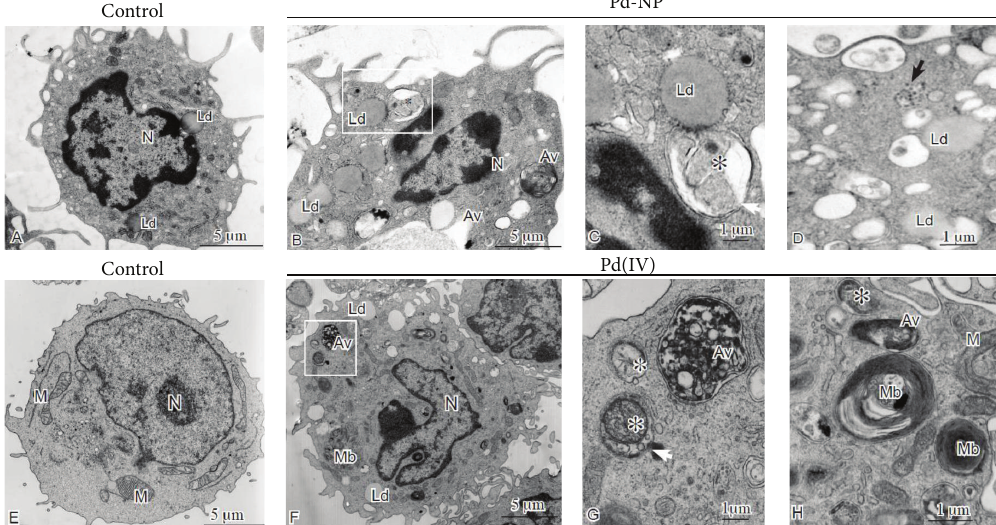
Figure 3: Ultrastructural alterations observed in peripheral blood mononuclear cells exposed to Pd-NP and ions. The upper panels show alterations observed in cells exposed to 10 𝜇 g mL −1 Pd-NP (B-D) relative to unexposed control (A); the lower panels (F-H) exemplify, relative to control (E), the alterations seen in PBMCs exposed to 0.1 𝜇 gmL −1 Pd (IV) ions. PBMCs exposed to cobalt NPs and ions show numerous autophagic vacuoles (Av) at different stages of maturation, often enclosing damaged mitochondria (indicated by asterisks in C and G and white arrow in G). Accumulation of lipid droplets (Ld) and multilamellar bodies (Mb), membrane-bound structures composed of concentric membrane whorls, is also readily evident. Agglomerates of electron-dense nanosized particles, consistent with internalized Pd-NP, are present within or near cytoplasmic vacuoles in PBMCs (indicated by black arrows in D). Compared to the untreated controls, the PBMCs exposed to Pd-NP and ions show increased membrane ruffling and more indented nuclei (B and